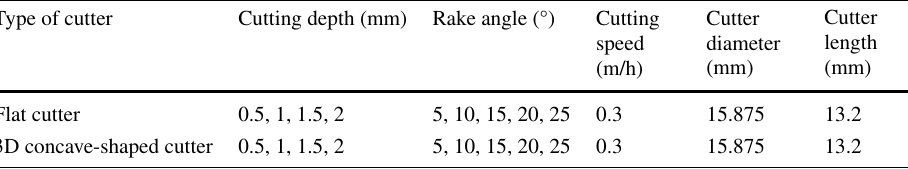
Table 4 Simulation parameters for cutter scraping and breaking